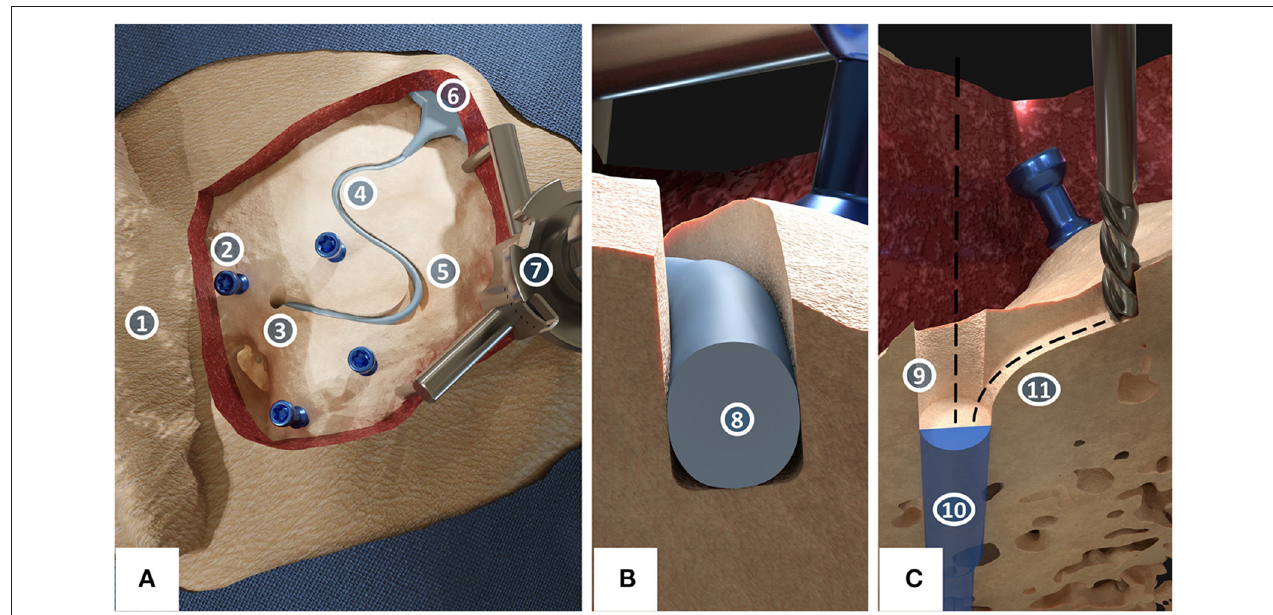
FIGURE 1 | The proposed concept for robotic milling of electrode lead channels during robotic cochlear implantation. (A) Surgical site of a left ear with its pinna (1) after the incision and placement of four fiducial screws (2) in which center the middle ear access hole (3) has been drilled. The electrode lead lies within the milled channel (4) and channel widenings (5) while the receiver-stimulator (6) is placed in a subperiosteal pocket. The patient marker attachment tripod (7) is fixed to the skull using a fifth screw. (B) Cross-sectional view of the immobilization of the electrode (8) in the channel with a slight press fit. (C) Cross-sectional view of the access point preparation (9) for the planned middle ear access drill hole (10). The sharp edge between the drill hole and the channel has been rounded off to create a smooth tunnel-to-surface transition